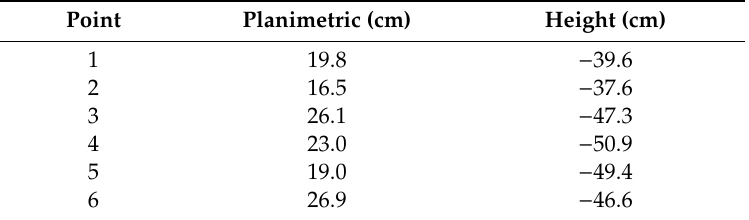
Table 3. Planimetric and height di ff erences computed in correspondence to six points across the